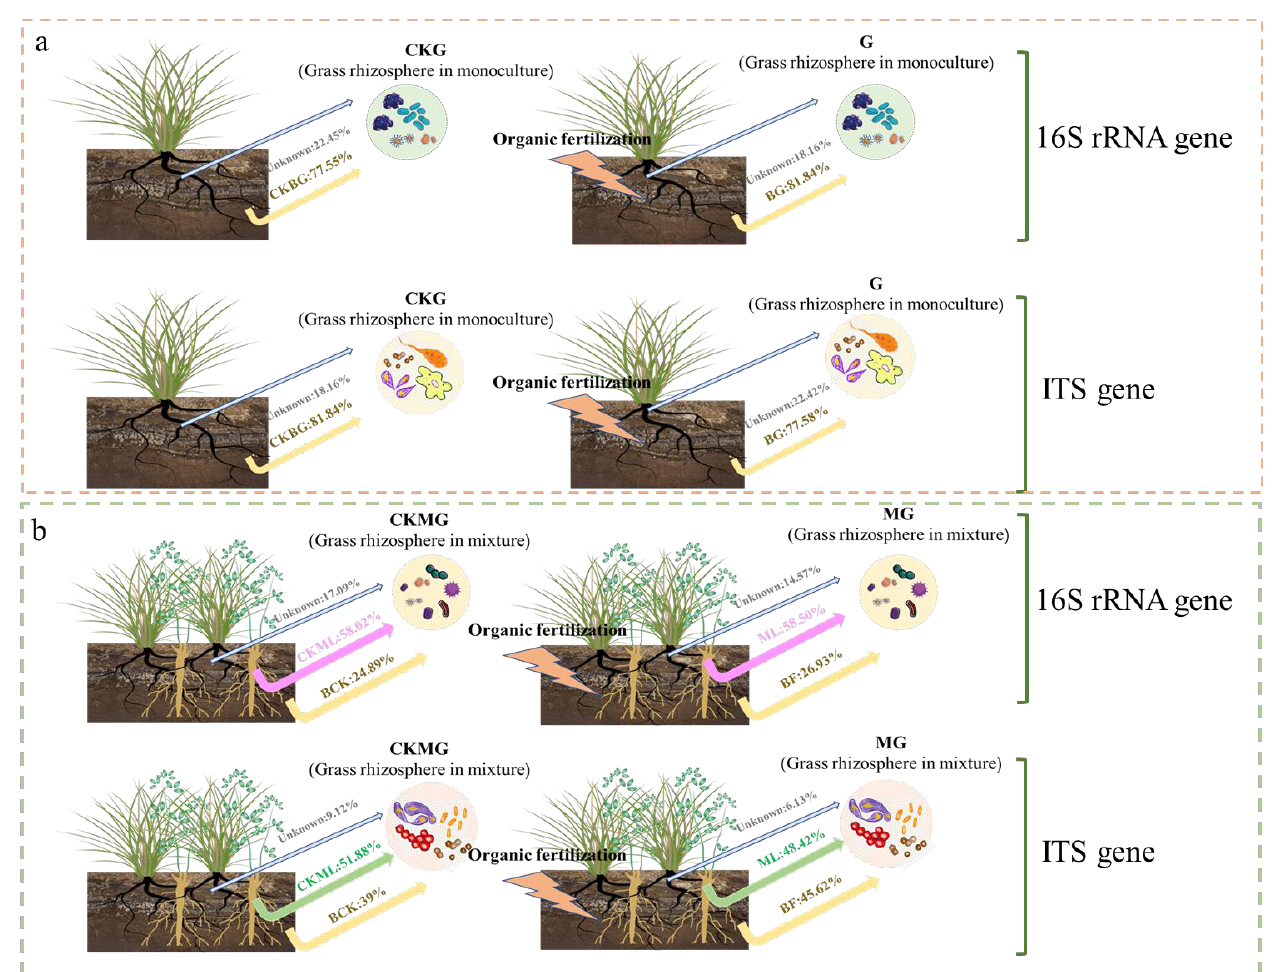
Figure 3. Source tracker analysis. Source tracker analysis proportion of rhizosphere microorganisms in monoculture and grass – legume mixtures. ( a ) Monoculture. ( b ) Grass – legume mixtures.